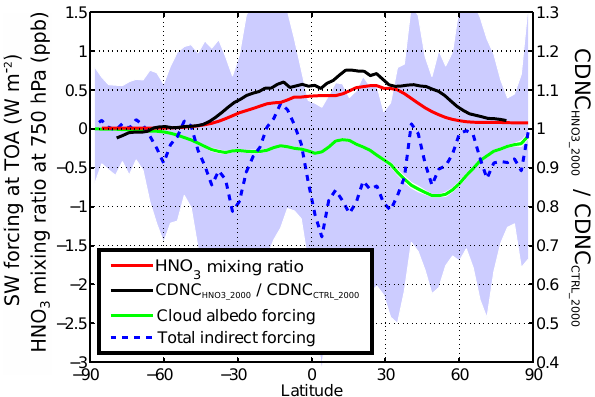
Fig. 3. Zonal average nitric acid mixing ratio at 750hPa (ppb), cloud albedo forcing (Wm − 2 ) (experiment HNO3 DIAG 2000) and total indirect forcing (Wm − 2 ) due to inclusion of nitric acid. The total indirect forcing is calculated as the difference in top- of-atmosphere short-wave fluxes between experiments HNO3 2000 and CTRL 2000. Also shown is the ratio of CDNC at the 750hPa level between experiments HNO3 2000 and CTRL 2000. The blue shading corresponds to standard deviation of the total indirect forc- ing. The standard deviation is presented also for the cloud albedo forcing, but it is almost indistinguishable from the green